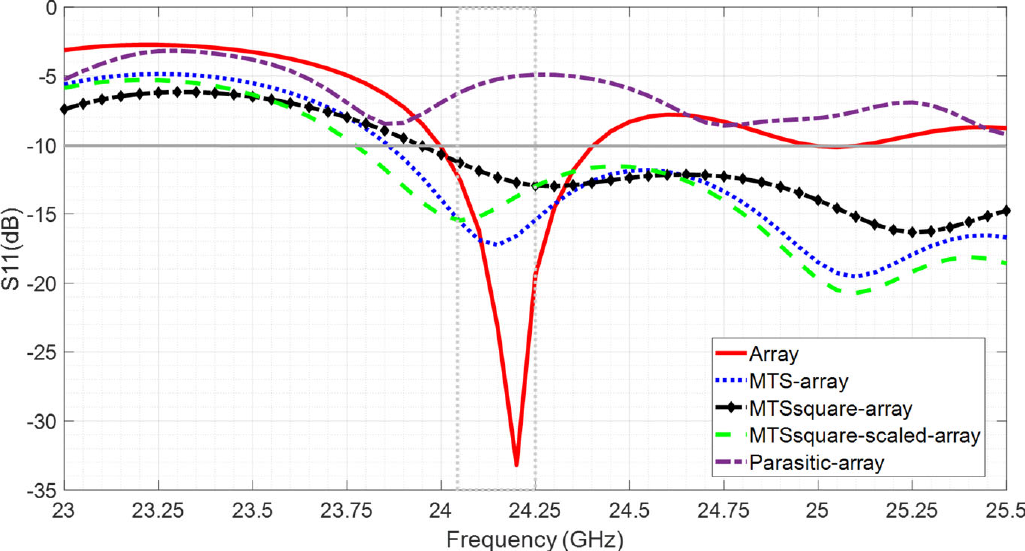
Figure 5. Simulation results for the reflection coefficient, S 11 (dB), for the antennas under analysis. The most significant advantage comes from the fact that the highlighted increase in bandwidth is accompanied by an improvement in gain and radiation efficiency, and